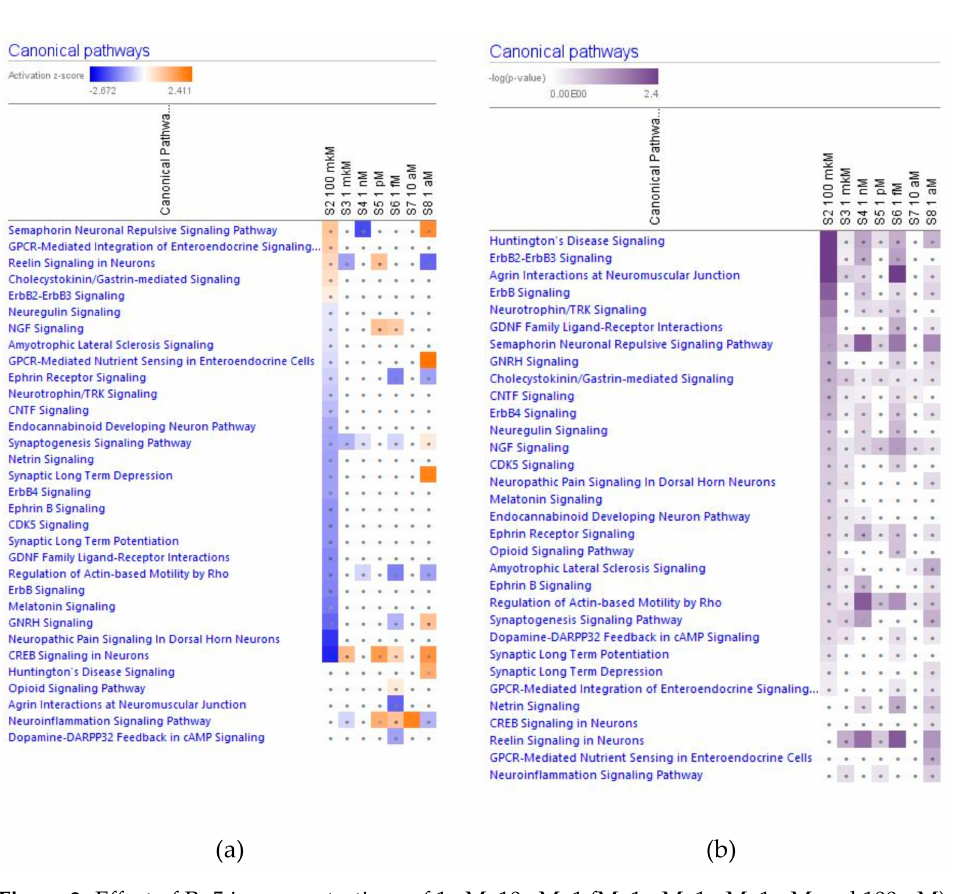
Figure 2. Effect of Rg5 in concentrations of 1 aM, 10 aM, 1 fM, 1 pM, 1 nM, 1 µ M and 100 µ M) on neurotransmitters and nervous system signaling. ( a ) Brown color depicts predicted activation, blue color—predicted inhibition of signaling pathway; symbol shows that the activation z-score was <2. ( b ) Symbol shows that the − log p -value was